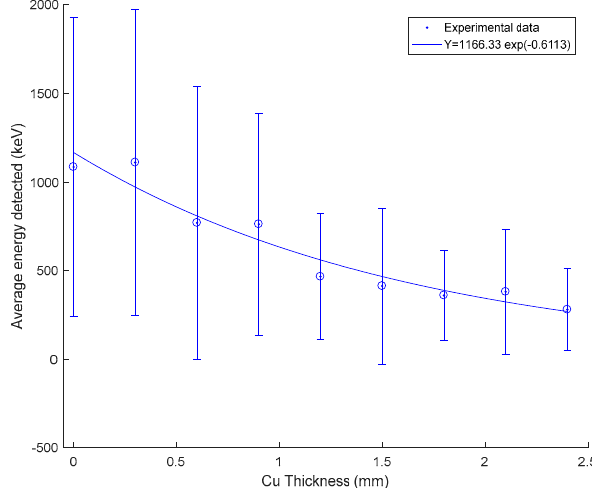
Figure 2. In spite of the two anomalies for copper shield thickness of 0.3 mm and shield thickness of 2.1 mm, the average energy data in above Table 1 could be fitted to a curve of first order exponential form with a tendency to show higher copper shield thickness reducing the average of the total detected energy.